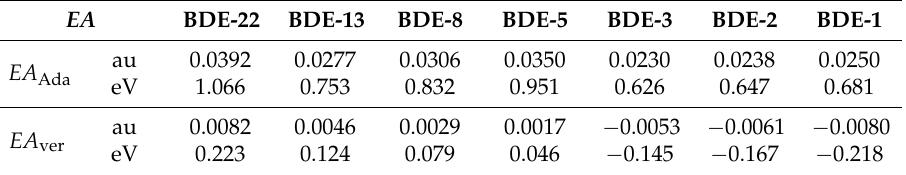
Table 7. Electron affinities ( EA Ada and EA ver ) of the selected